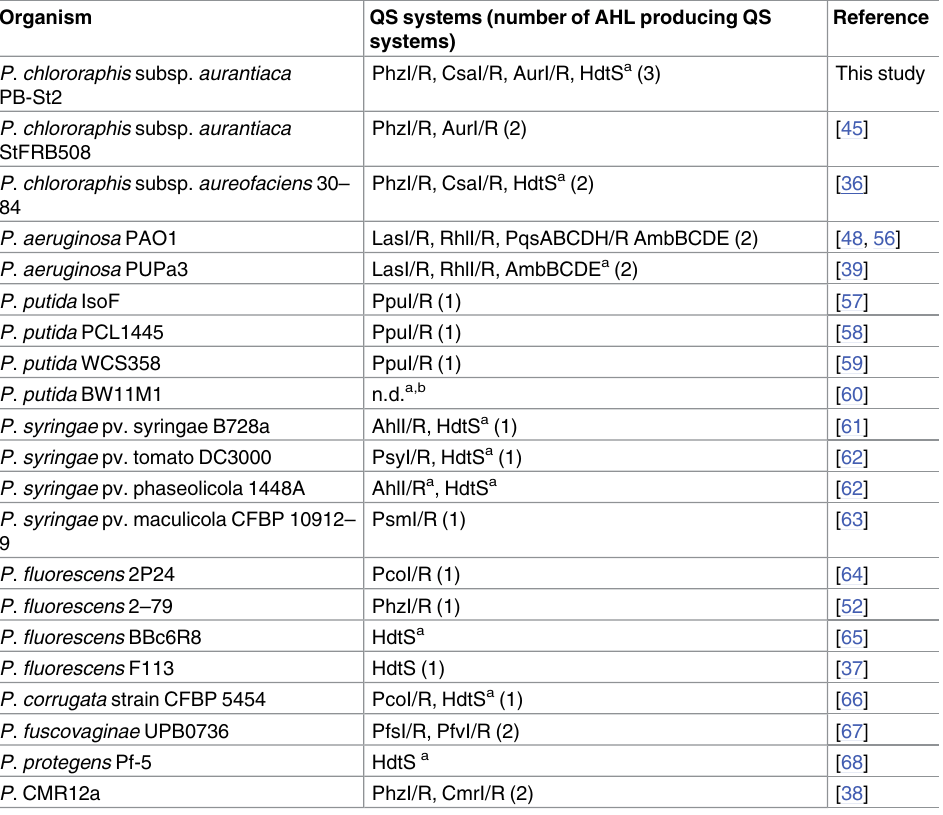
Table 3. QS systemsof in-depth investigated Pseudomonas